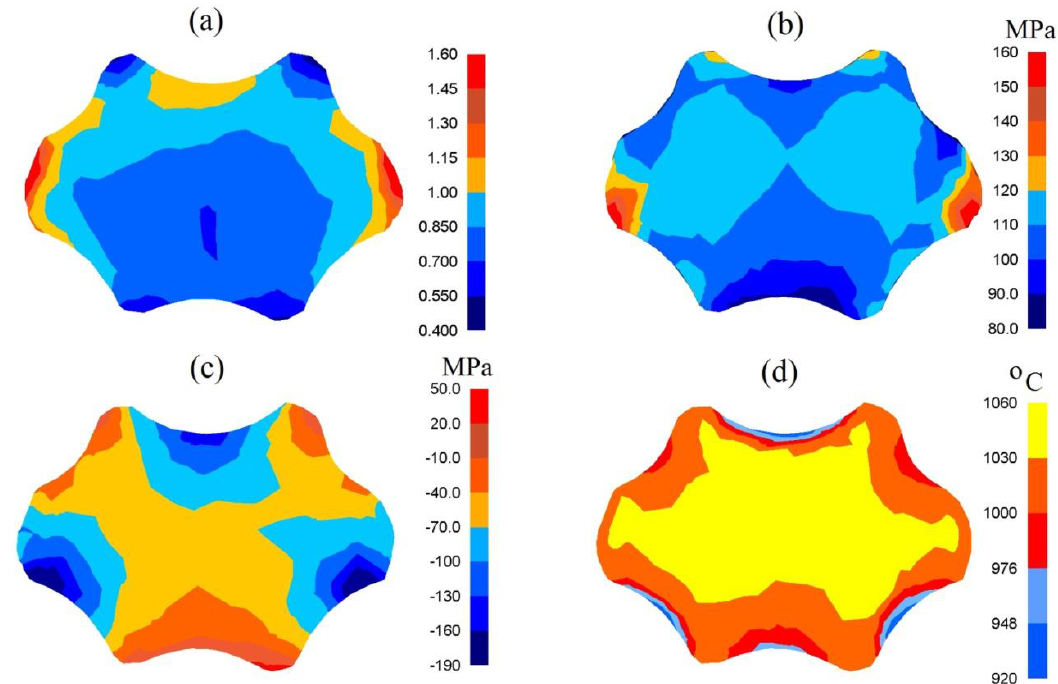
Figure 7. Distribution of the effective strain ( a ), effective stress ( b ), mean stresses ( c ) and temperature ( d ) after the cogging process in the assembly of three-radial anvils after the second pass (reduction ratio 0.70).